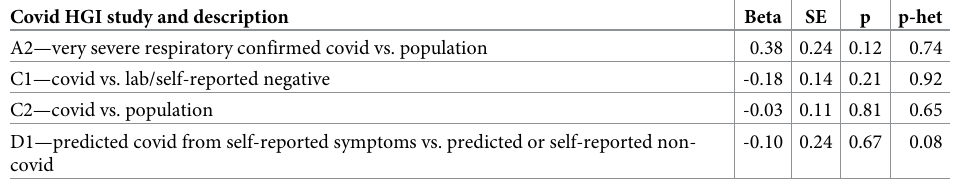
Table 2. Covid Host Genetics Initiative [31] Release 3 (accessed: 12 th October 2020) summaries for p.Lys26Arg (rs4646116). Covid HGI study and